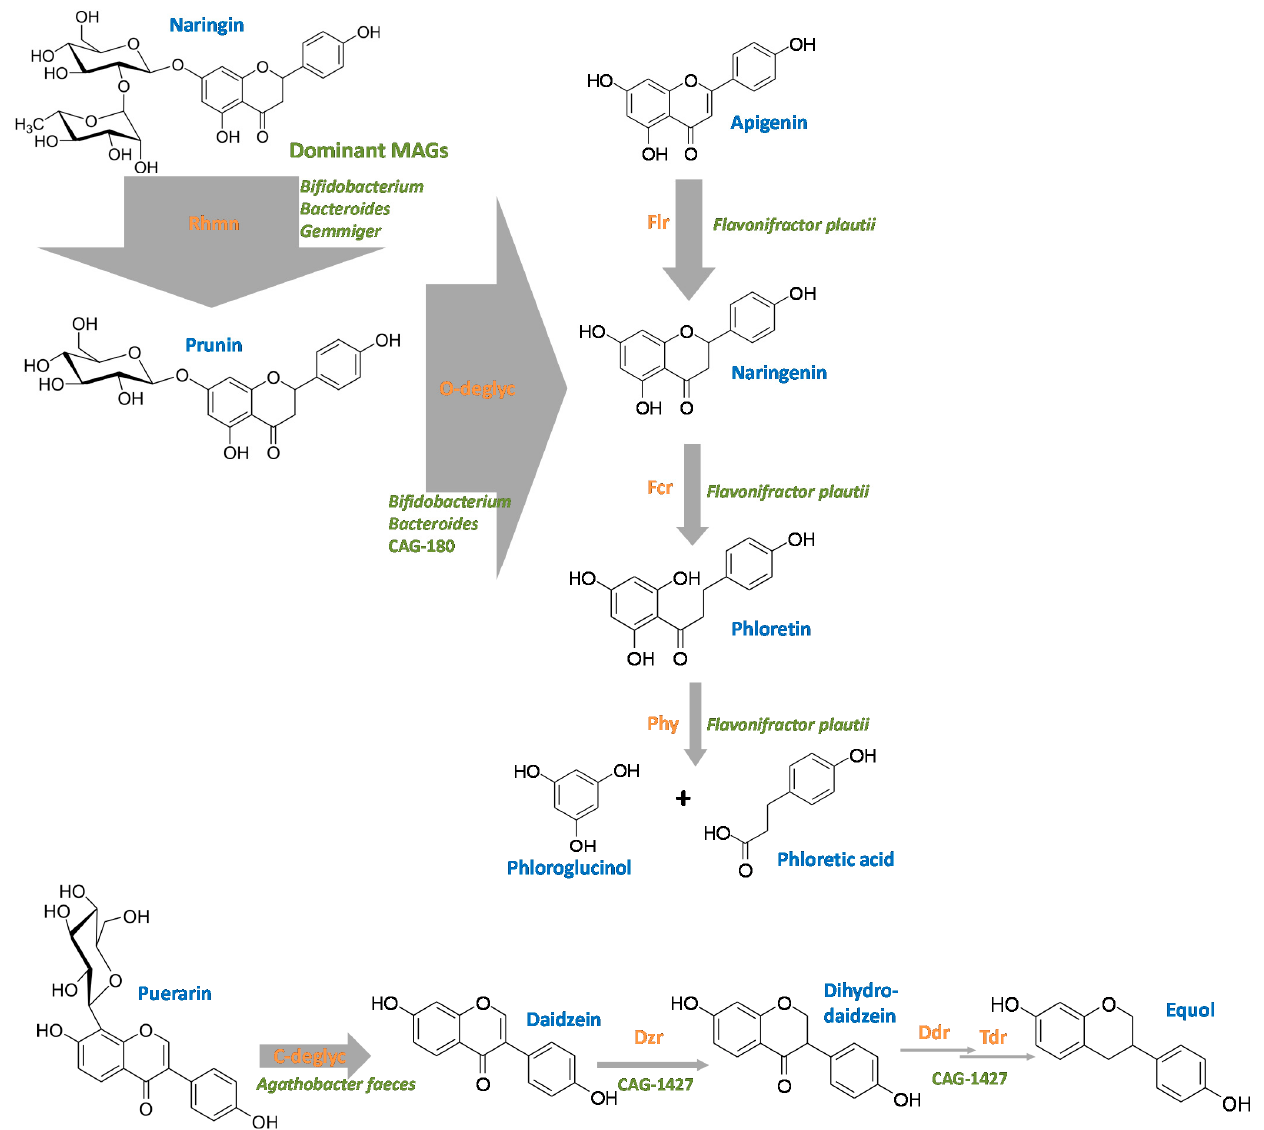
Figure 10. Overview of the flavonoid conversion pathways in the human gut based on the MAGs study. Thickness of arrows reflects the abundance of observed hits to the sequences of the characterized flavonoid-transforming enzymes. Color code: blue, flavonoid trivial names; orange, flavonoid-converting enzymes; green, most abundant bacterial species carrying out the corresponding reaction in this analysis. For abbreviations, see text.